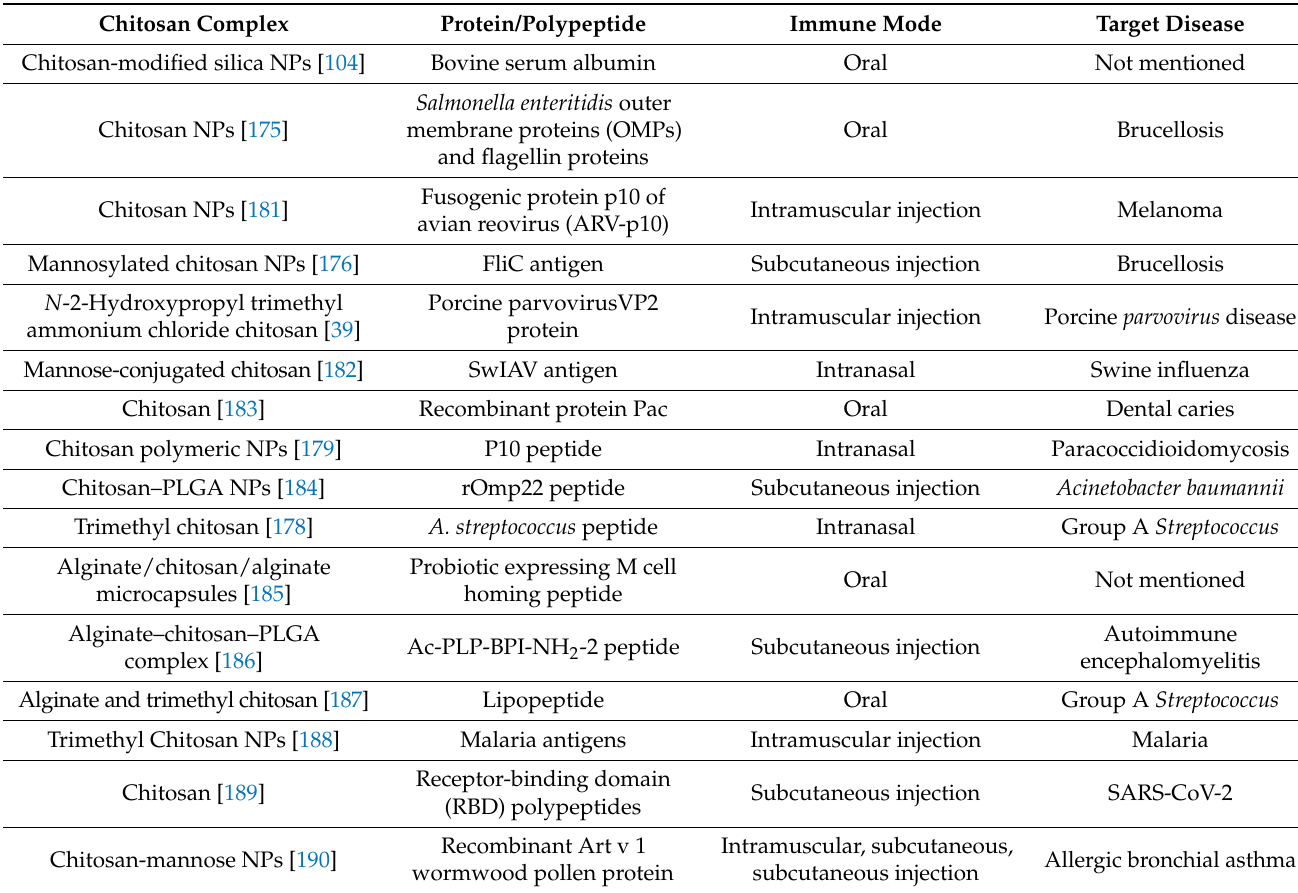
Table 6. Application of chitosan in protein vaccines and polypeptide